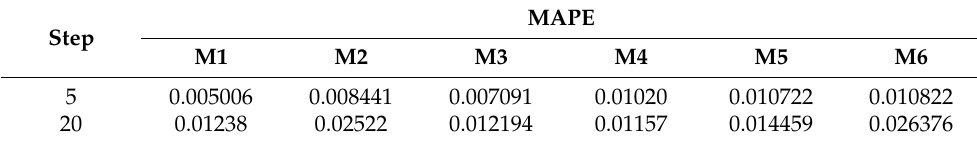
Figure 11. Using CEEMDAN to predict at different starting points. 350 min, (a) and partial enlarged figure ( b ).